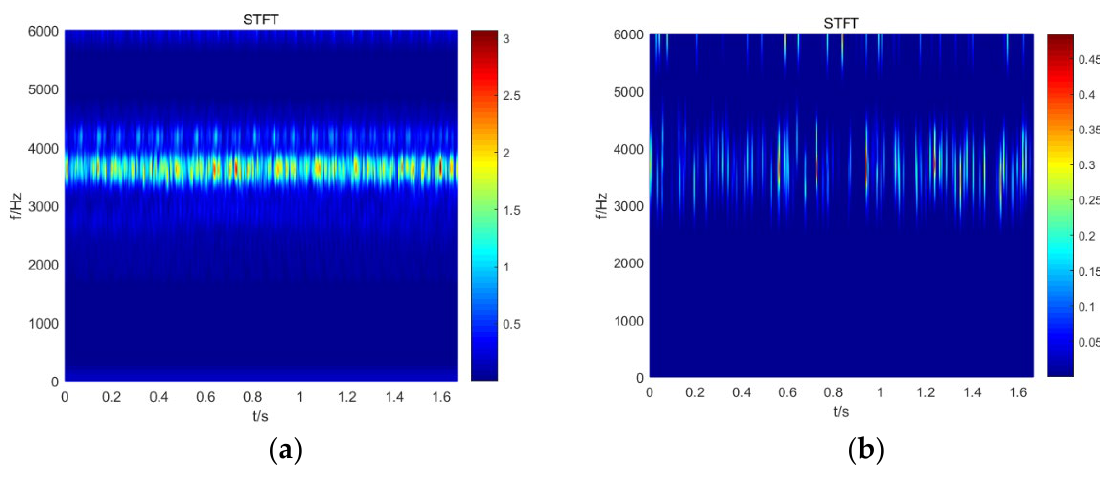
Figure 9. In 60 h: the STFT of ( a ) harmonic component; ( b ) impulse component.